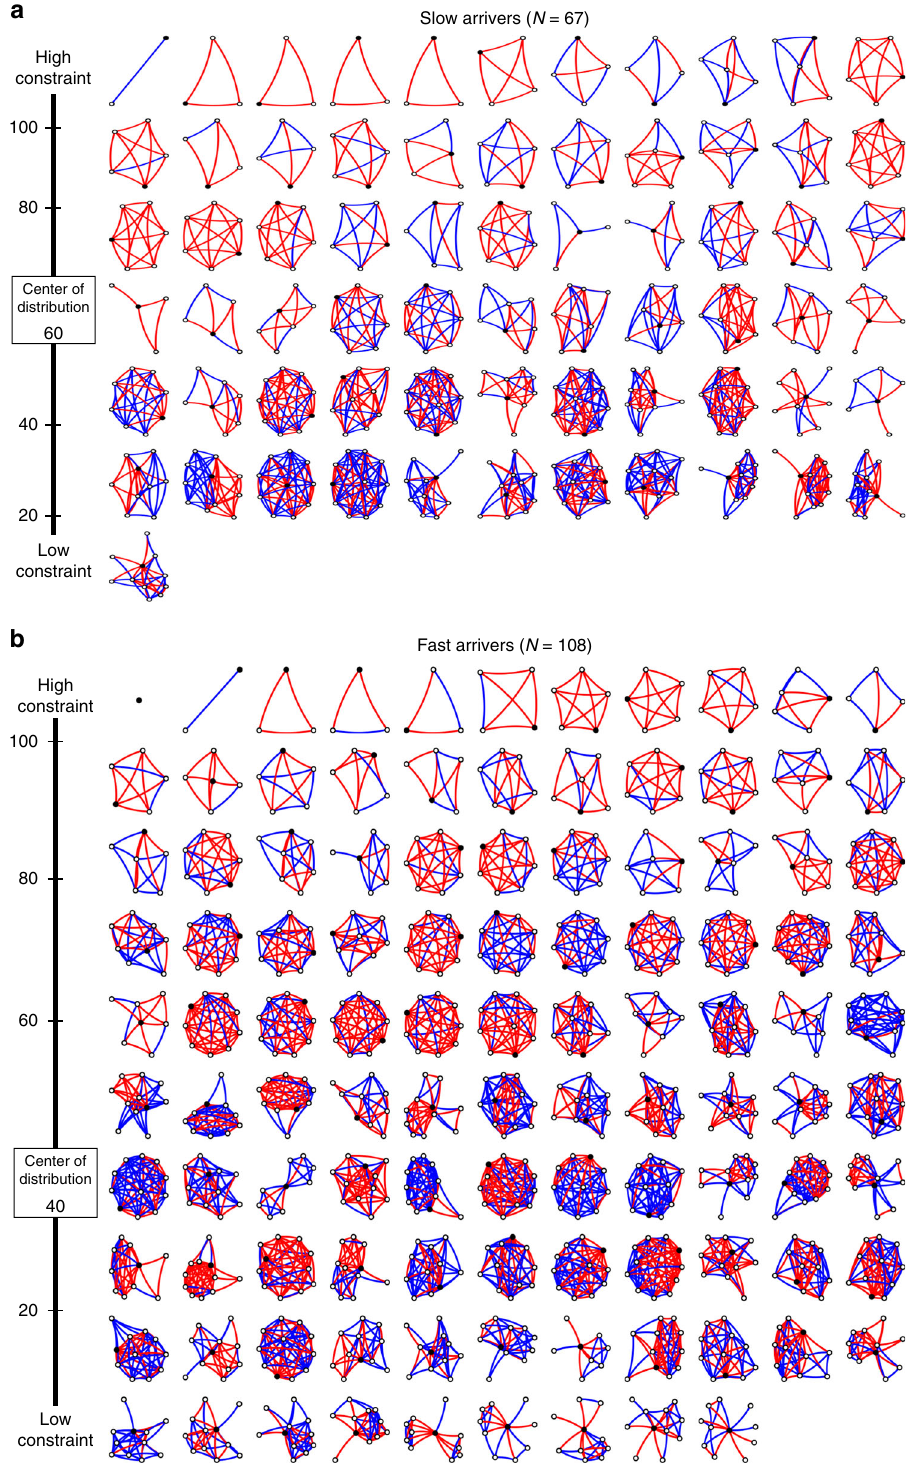
Fig. 2 Personal networks of patients with ischemic stroke, according to slow and fast arrival. Each black circle represents one patient in the study embedded inside his/her social network. Line color indicates strength of relationship: red lines are strong ties and blue lines are weak ties. Networks are arranged from highest constraint (top left) to lowest constraint (bottom right) with scale and median along the left margin. In general, slow arrivers ’ networks had higher constraint compared to fast arrivers ’